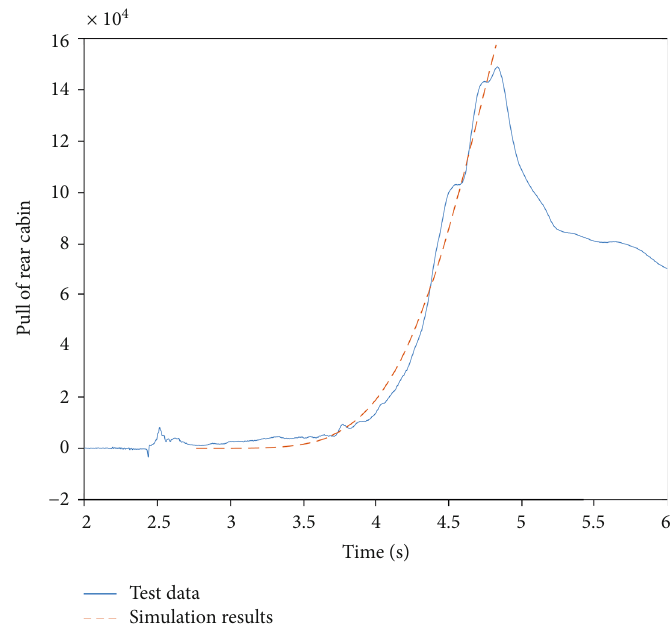
Figure 16: Pull of rear cabin-time diagram.